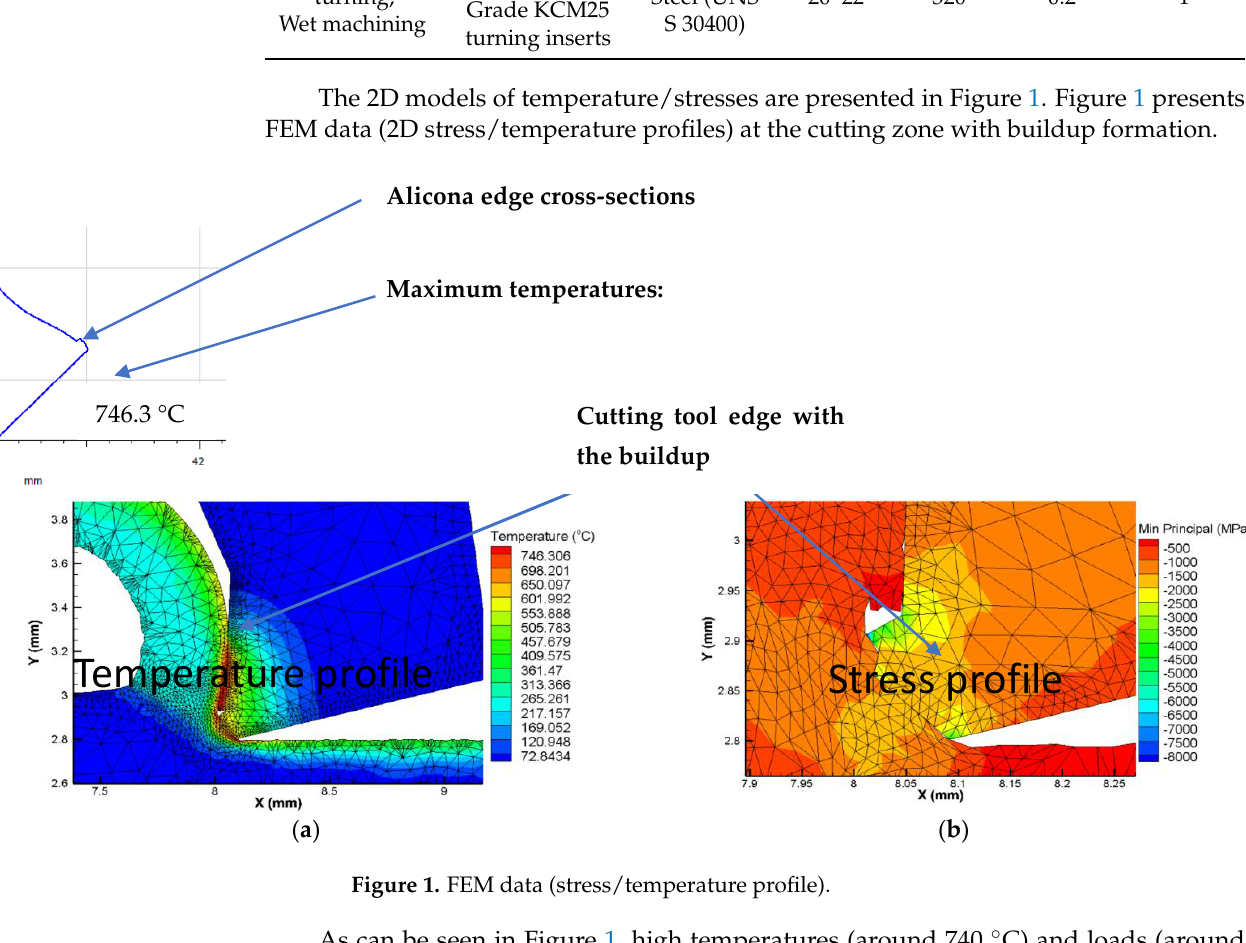
Table 2. Cutting parameters used in the experiments.